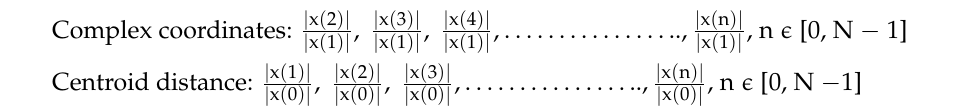
280 Table 8. Distances between Fourier descriptors for polygon #1004. Distance between Fourier Descriptors [26–29]